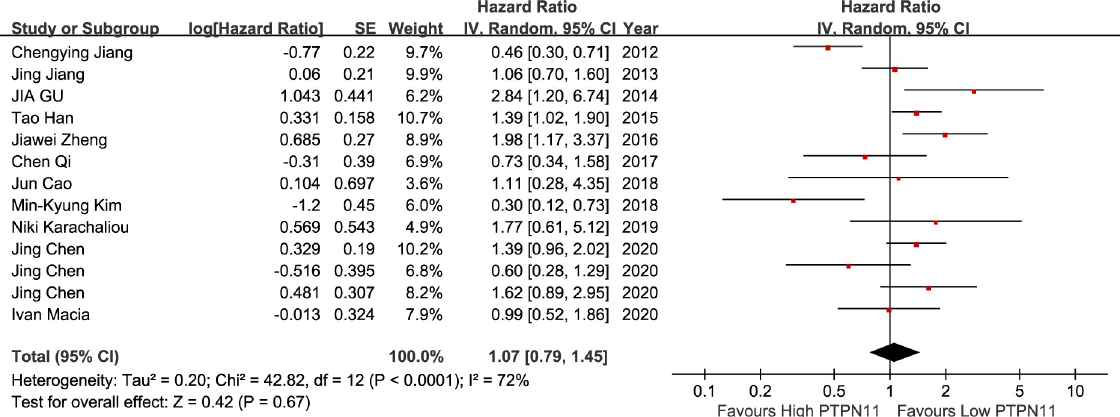
Fig 4. A forest plot for the association between SHP2 expression levels with with